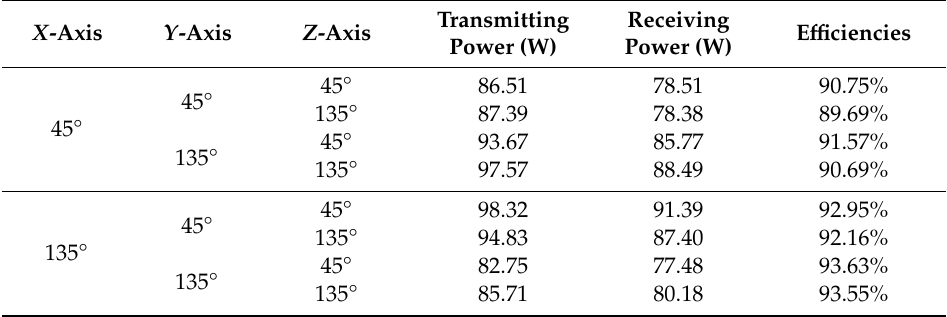
Table 1. Simulation results of directivity when receivers rotate over three axes.